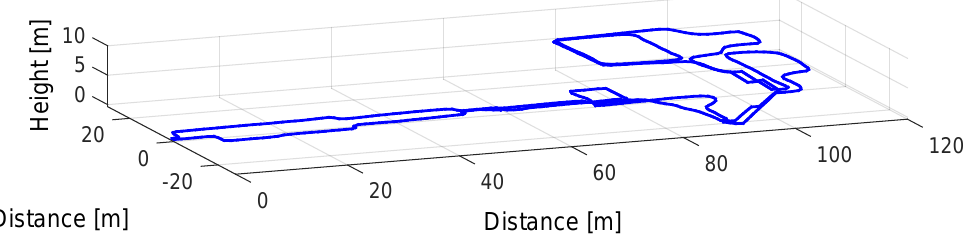
Figure 13. 3D view of the trajectory of a 10min walk at the Deutsches Museum,